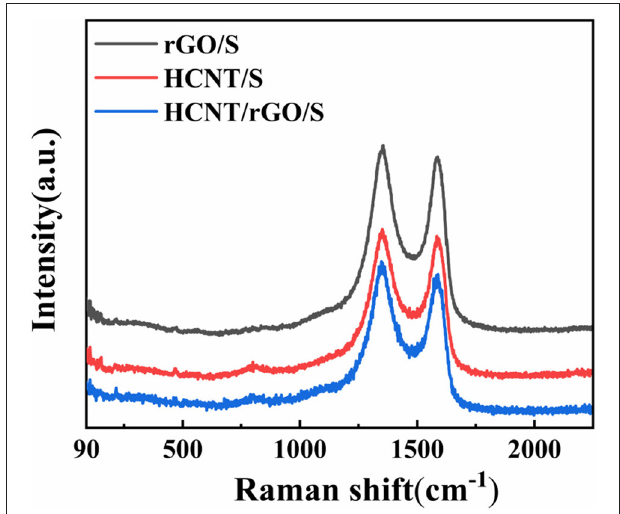
FIGURE 3 | Raman spectra of helical carbon nanotubes (HCNT)/sulfur (S), reduced graphene oxide (rGO)/S, and HCNT/rGO/S.